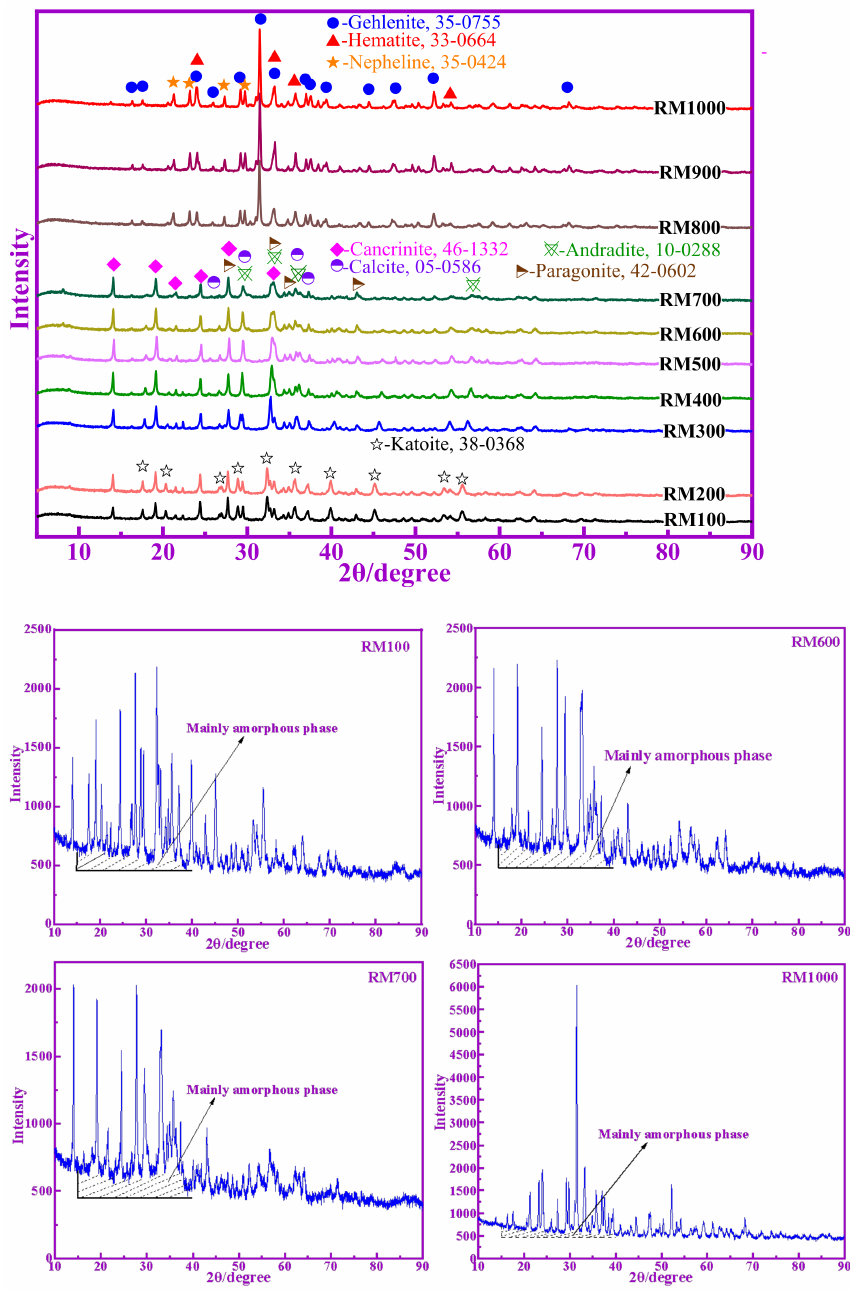
Figure 1. XRD patterns of calcined RM at different